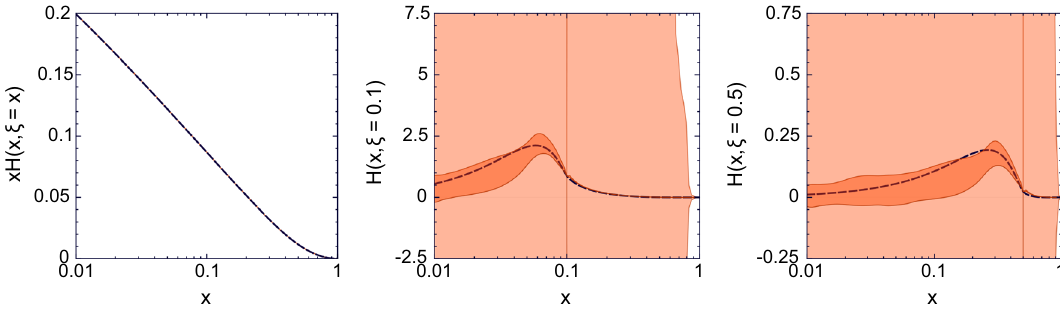
Fig. 7 Result of constraining the ANN model using 200 points evalu- ated with GK model [25–27] for sea quarks: x = ξ case, positivity not enforced, F D (β,α) not shown. See the text for more details. The com- parison is for (left) x = ξ , (center) ξ = 0 . 1 and (right) ξ = 0 . 5.